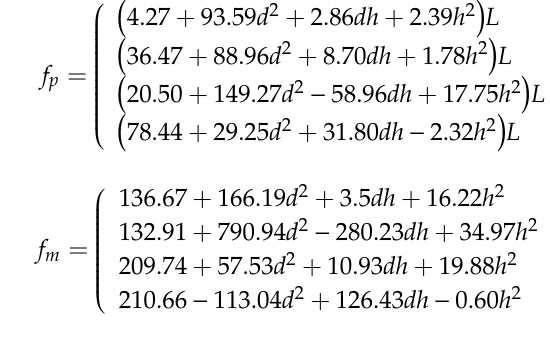
Table 1. Hydraulic design constraints for round pipes [34].